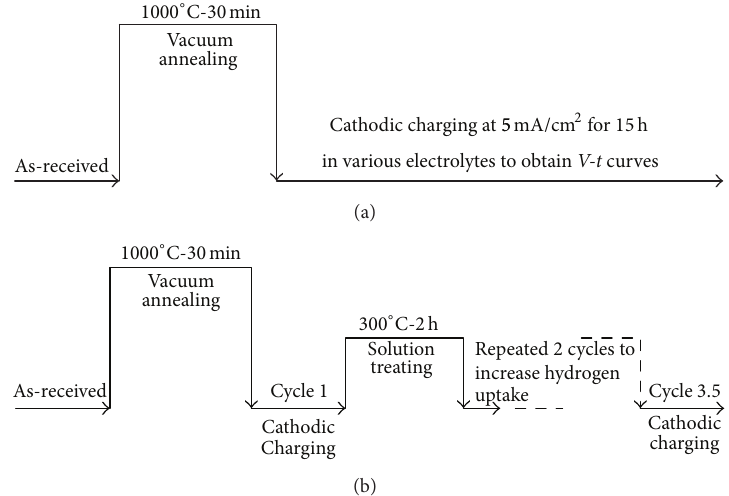
Figure 2: Schematic diagrams for (a) the process to monitor the variation of cathode potential versus time and (b) the cyclic hydrogenation- solution heat treating process to increase the hydrogen uptake of